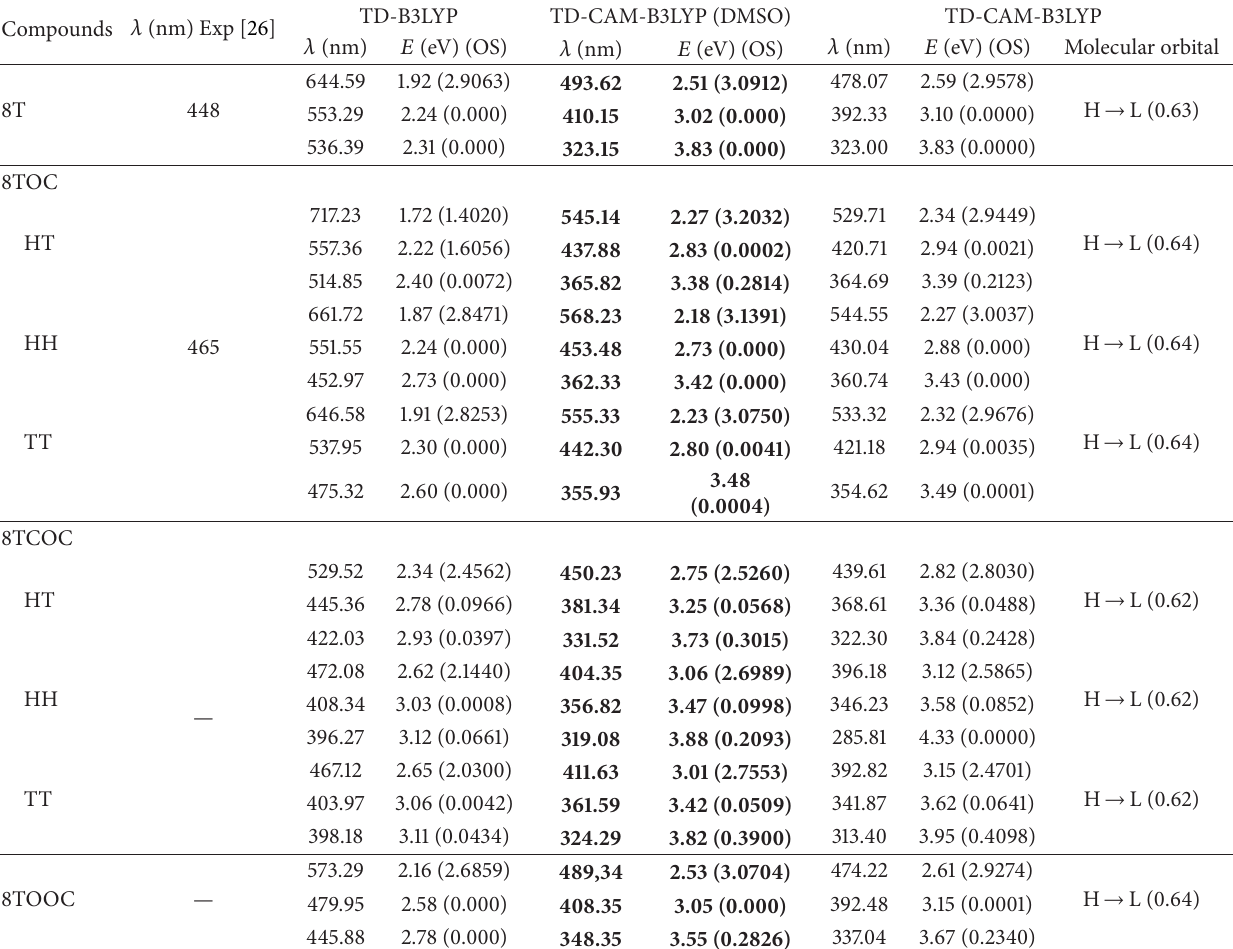
Table 4: Excitation energy values Δ𝐸 for the studied compounds obtained by TD-DFT/CAM-B3LYP, TD-DFT/ B3LYP with 6-31G (d,p) level. Compounds 𝜆 (nm) Exp